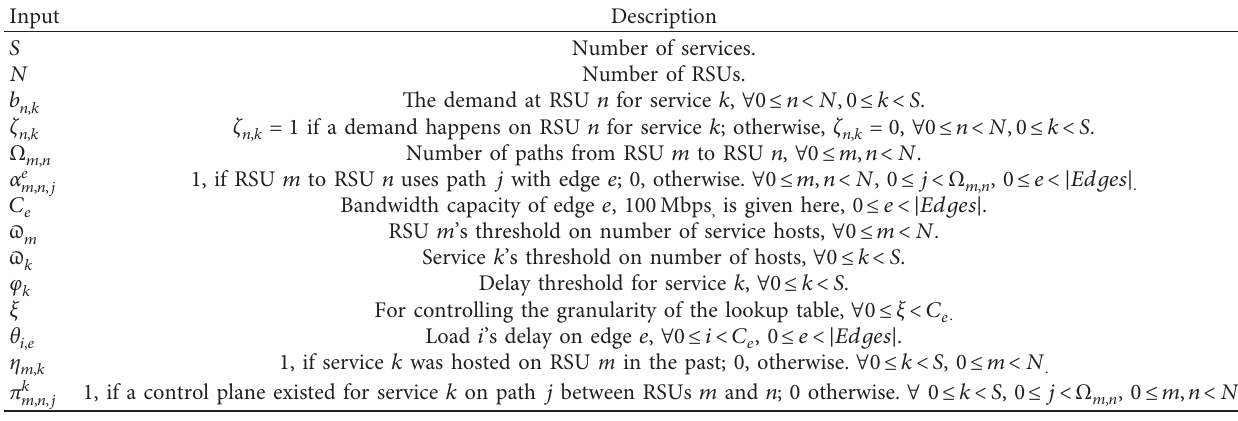
Table 1: Input parameters.